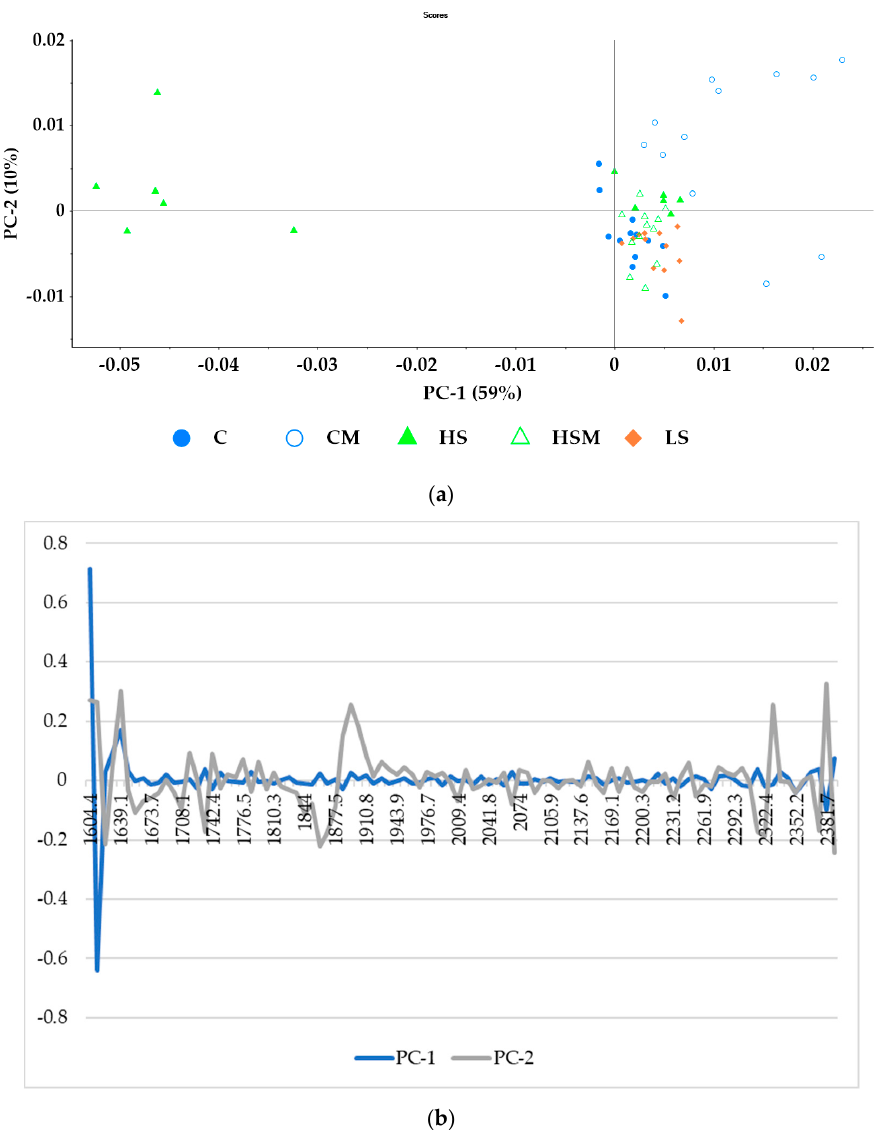
Figure 6. Principal component analysis (PCA) for the microPHAZIR TM berry absorbance values between 1600–2396 nm ( a ) and loadings ( b ). Abbreviations: C = control without misting; CM = control with misting; HS = high density smoke without misting; HSM = high density smoke with misting; and LS = low density smoke.